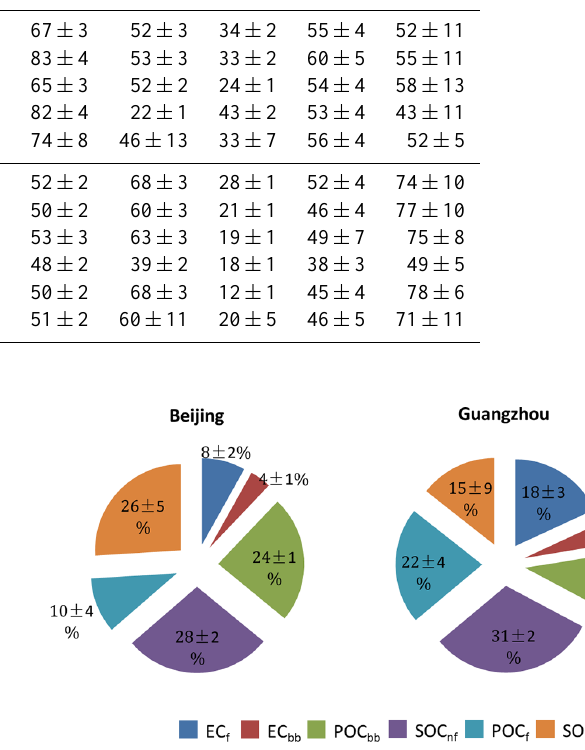
to total carbon with variability of the individual sources during the study. For model uncertainties of the individual fractions see Sect.